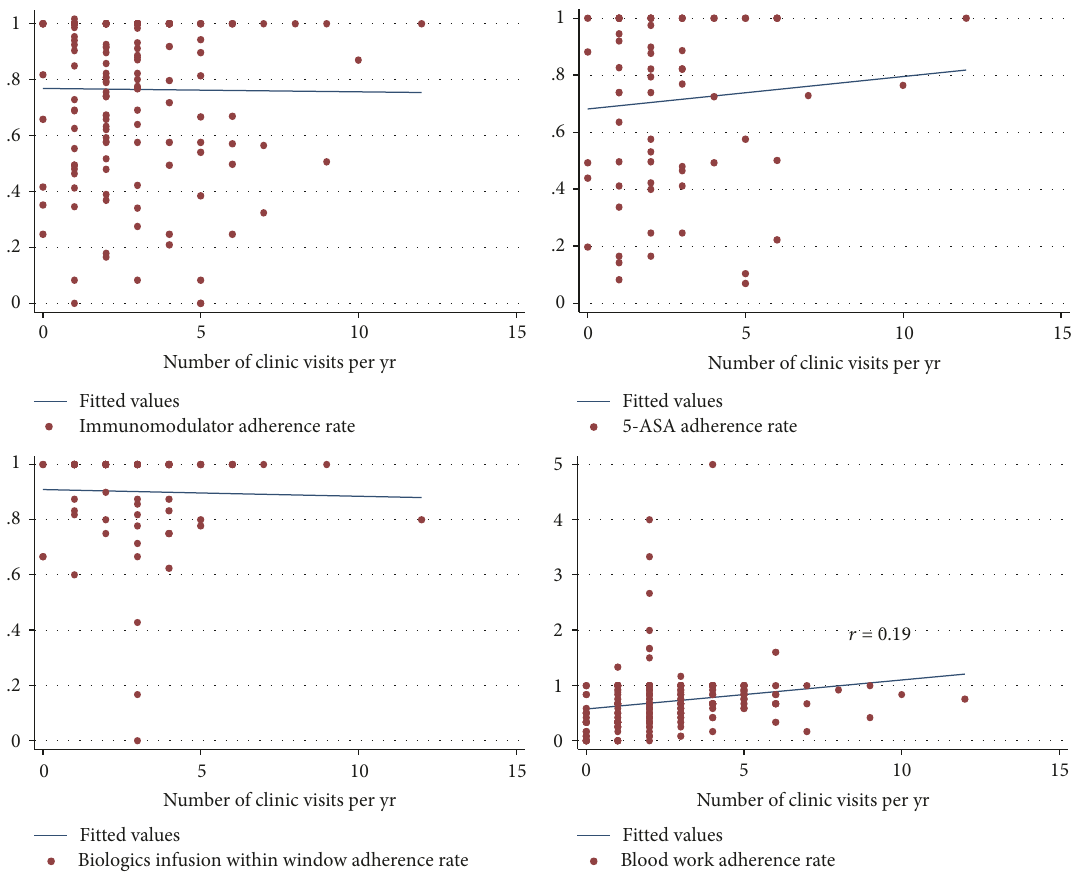
Figure 1: Lack of correlation between adherence rate and clinic